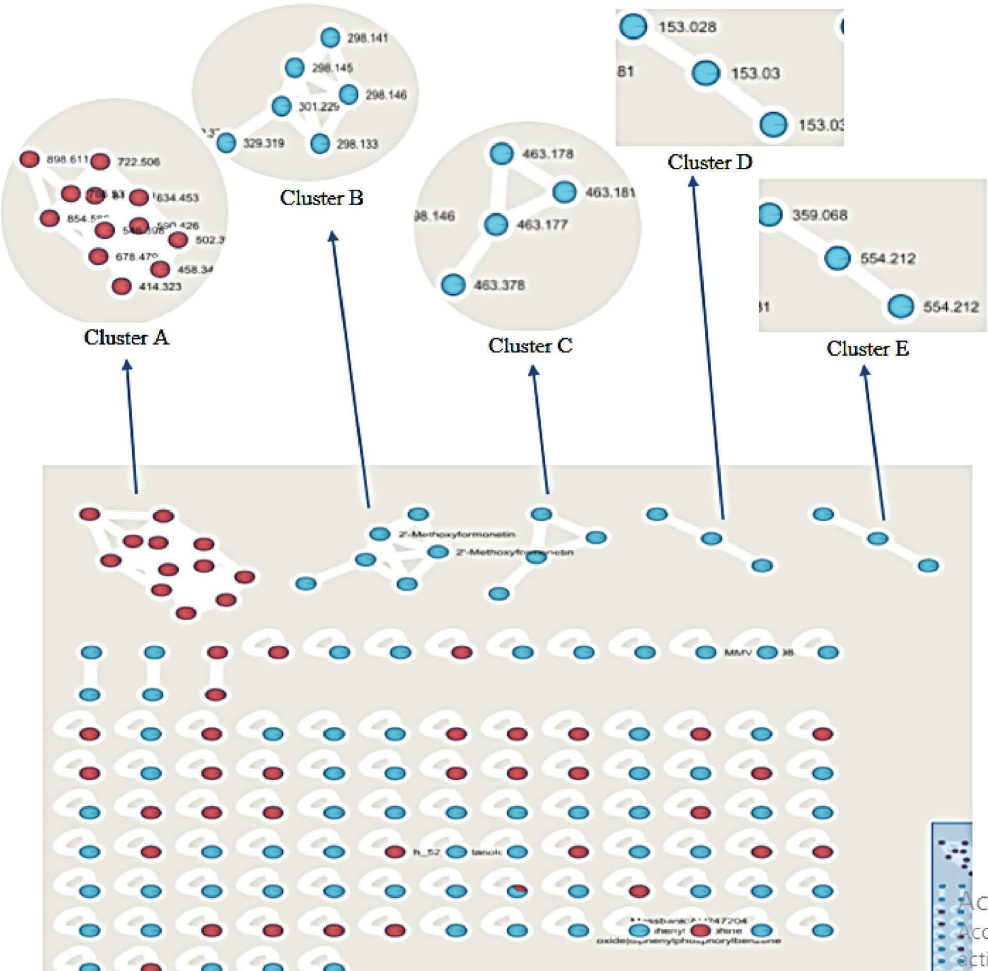
Figure 6: Molecular network of the ethanolic crude extract of Antrocaryon klaineanum